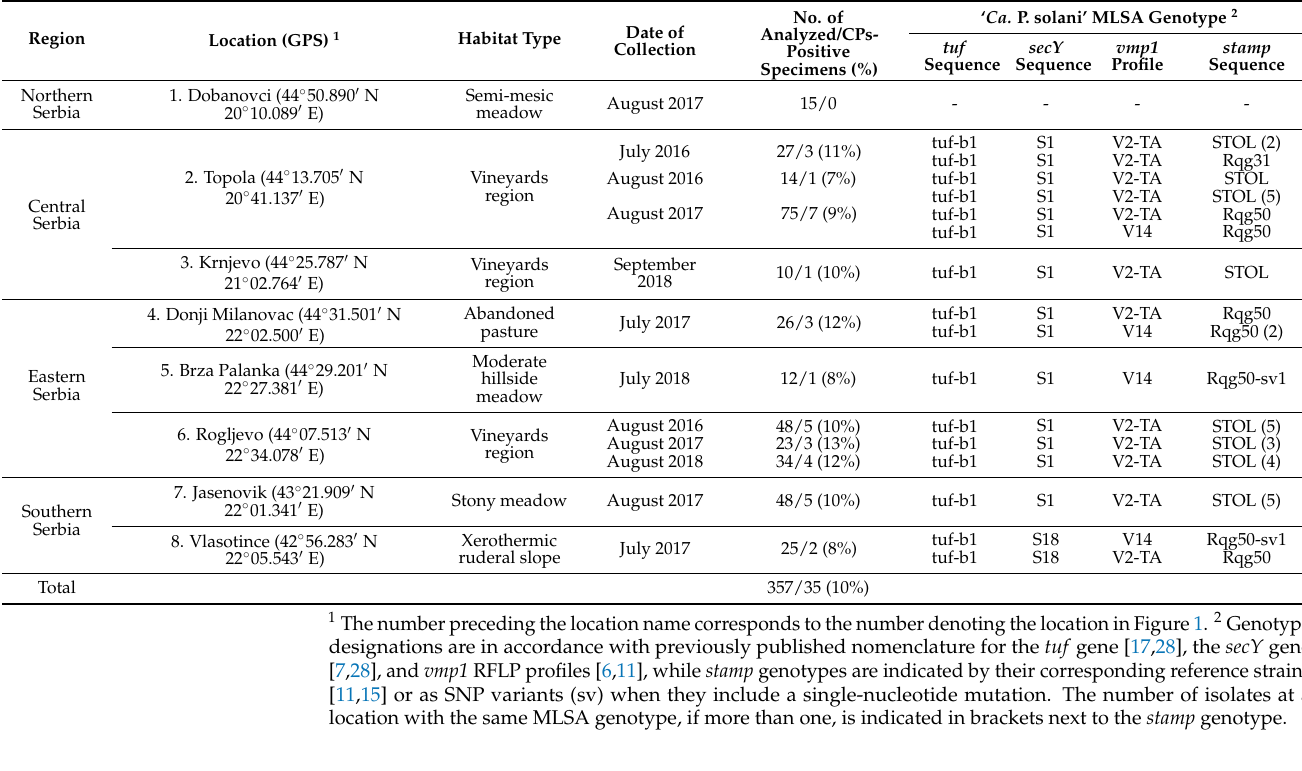
Table 1. Surveyed locations of D. europaea populations associated with diverse habitat types, with information on collection date, the number of collected/phytoplasma-infected specimens and ‘ Ca. Phytoplasma solani’ MLSA genotyping.